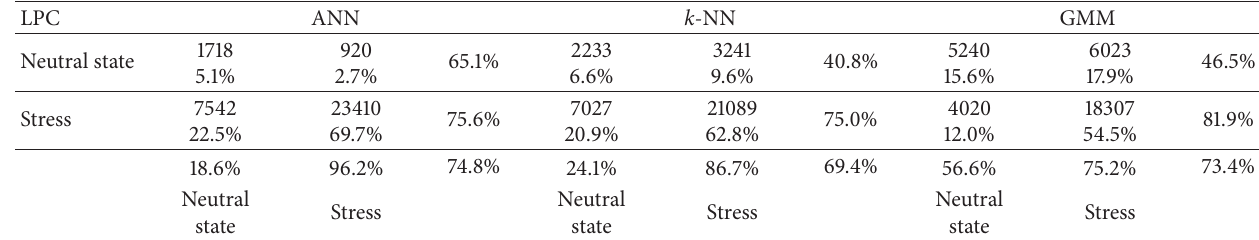
Table 2: Performance results of classifiers for LPC features.